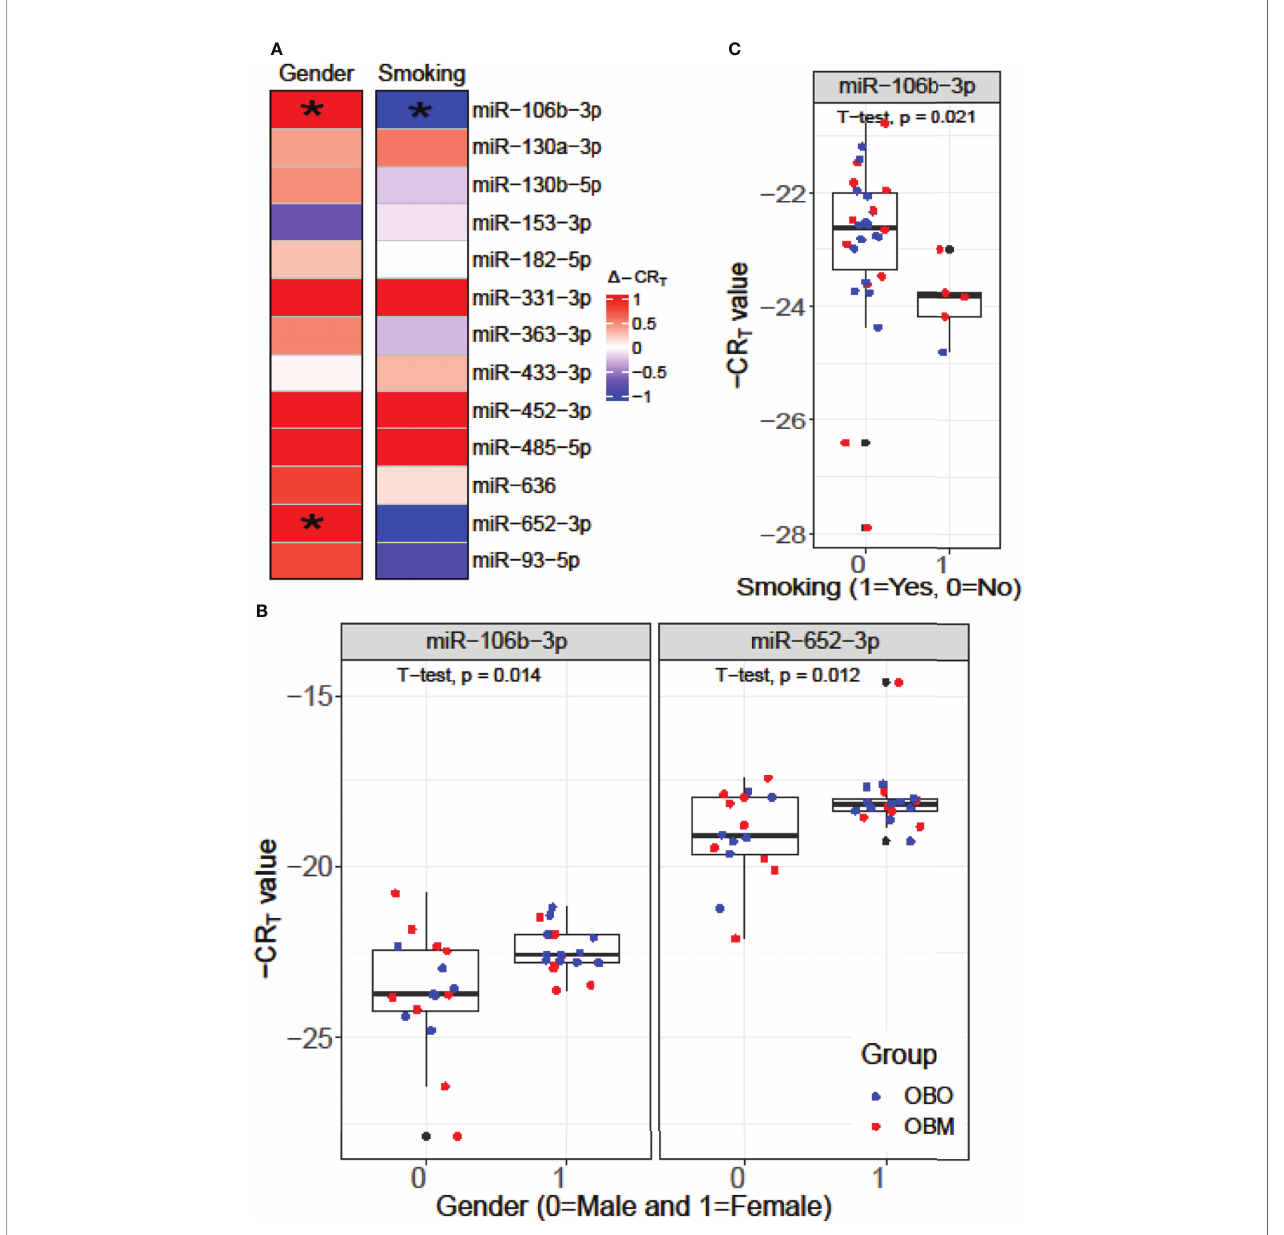
FIGURE 4 | (A) Comparison of the expression pattern of the 13 differentially expressed miRNAs for Gender and Smoking status of patients using a Student ’ s t-test. Here ‘ * ’ represents a signi fi cant association (p< 0.05). (B) Boxplot illustrating the signi fi cant difference in expression of miR-106b-3p and miR-652-3p between males and females. (C) Boxplot highlighting the signi fi cant difference in expression of miR-106-3p between patients who smoke versus those who don ’